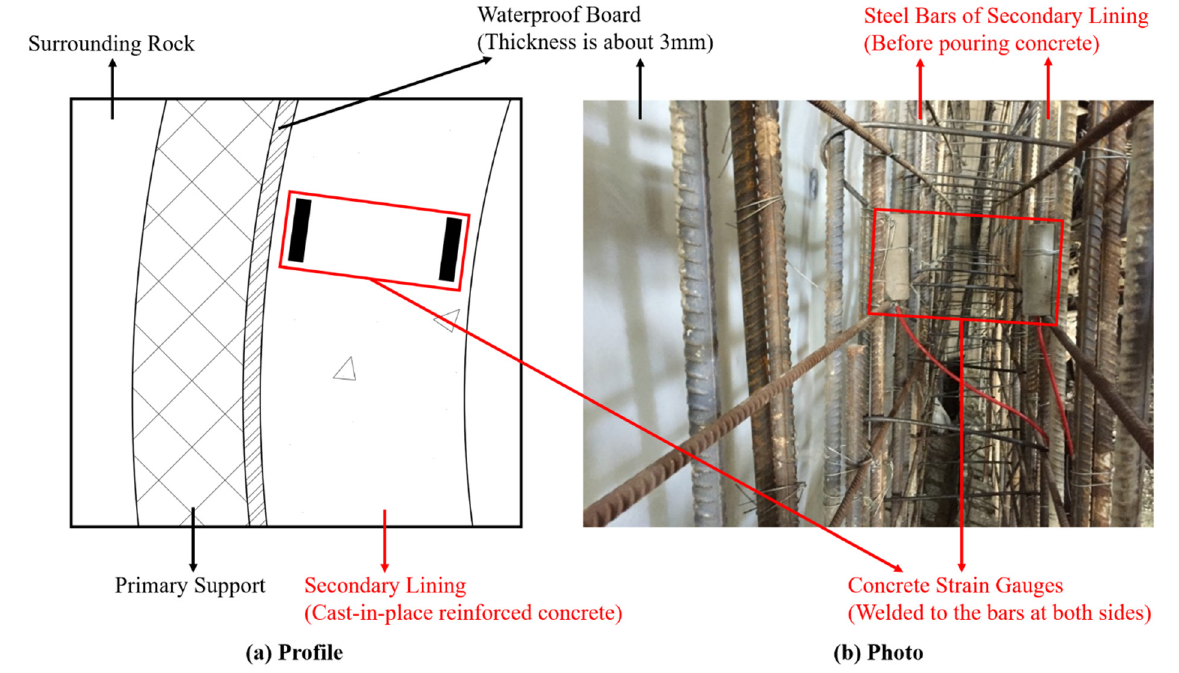
Figure 6. Concrete strain gauges in secondary lining. The most internal force of secondary lining can be obtained by the gauges.